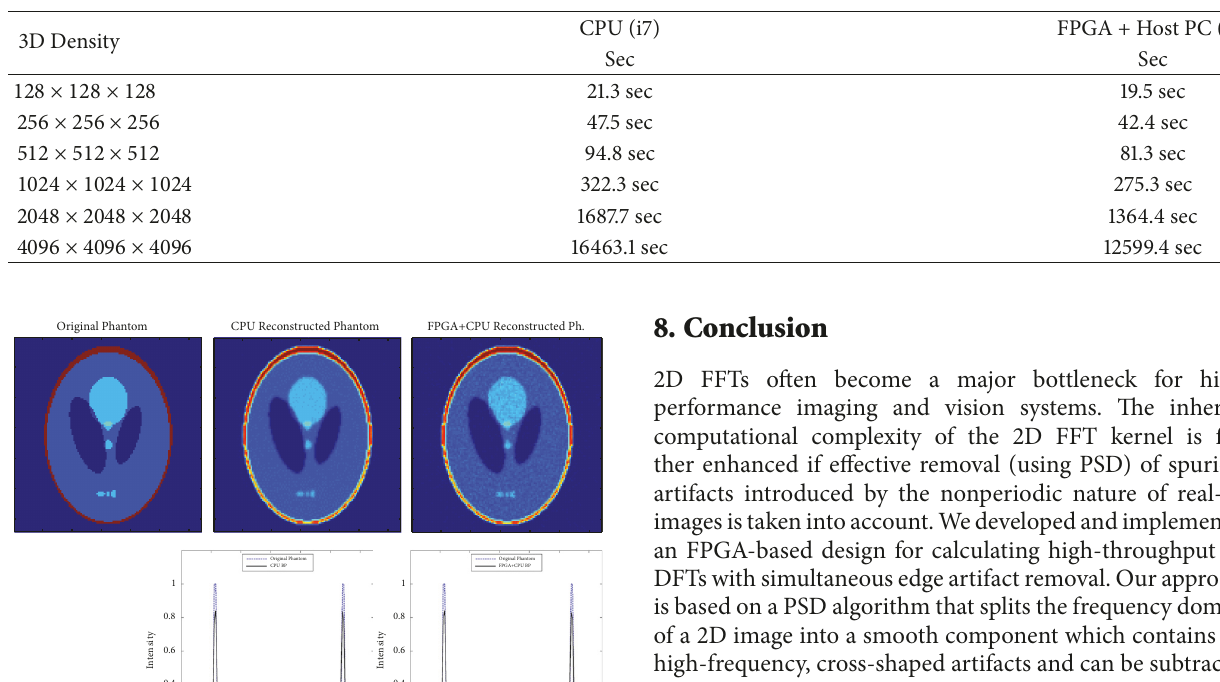
Table 5: Comparing filtered back-projection (FBP) runtime (as an application for using the proposed 2D FFT with simultaneous EAR).